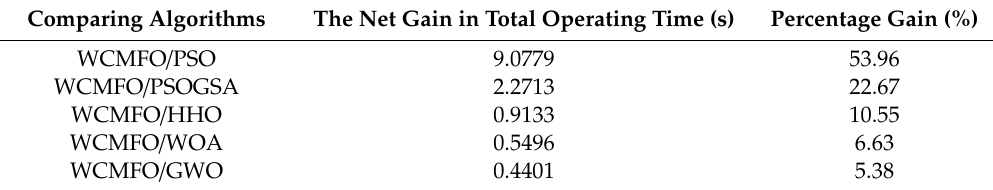
Comparison of the total net gain from water cycle–moth flame optimization (WCMFO)